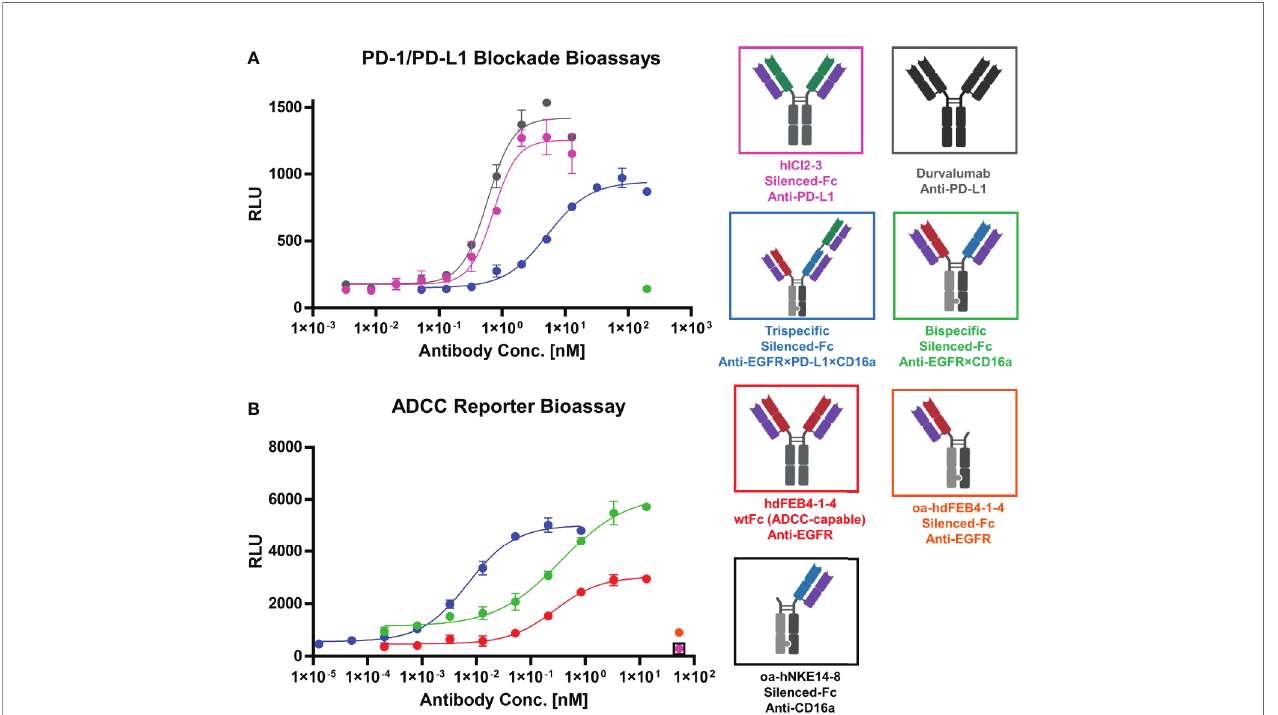
FIGURE 6 | PD-1/PD-L1 blockage and ADCC cell-based reporter assays. (A) PD-1/PD-L1 blockage assay. hICI2-3 (pink), durvalumab (gray) were tested in comparison to the trispeci fi c construct (blue) and the bispeci fi c construct (green). EC 50 values: durvalumab, 586 pM; hICI2-3, 728 pM; trispeci fi c, 5.2 nM. (B) ADCC reporter bioassay. Bivalent hdFEB4-1-4 with a wildtype IgG1 Fc (red) and the bispeci fi c construct with the LALA mutation were tested in comparison to the trispeci fi c antibody. As controls, one-armed hdFEB4-1-4 (orange), one-armed hNKE14-8 (black), and hICI2-3 were tested. EC 50 values: hdFEB4-1-4 (wtFc), 271 pM, bispeci fi c antibody, 362 pM; trispeci fi c antibody, 7.0 pM. A&B) Luciferase activity is plotted against the logarithmic antibody concentration. All measurements were performed in duplicates, and the experiments were repeated at least three times, yielding similar